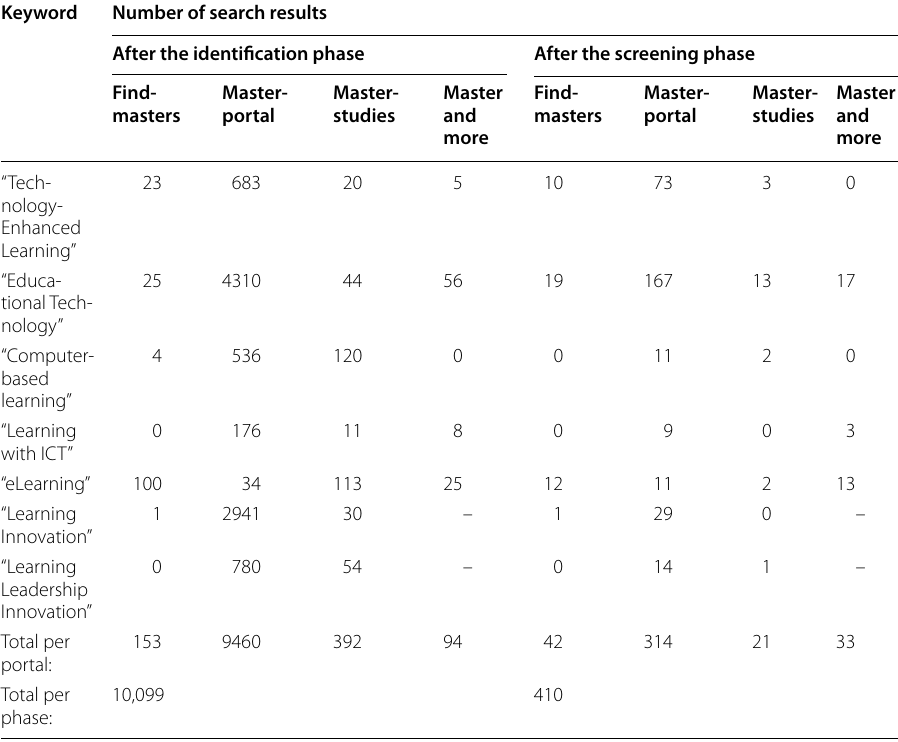
Table 1 Number of search results for english keywords Keyword Number of search